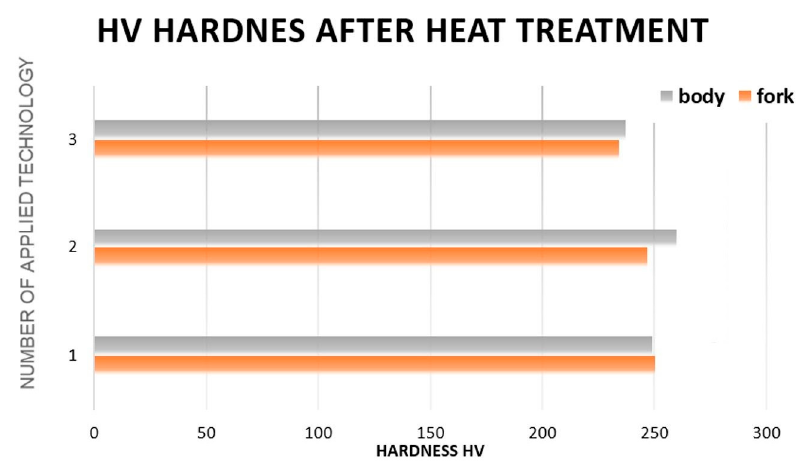
Figure 6. Microstructural test results for the three selected thermal treatment variants: thermal improvement.